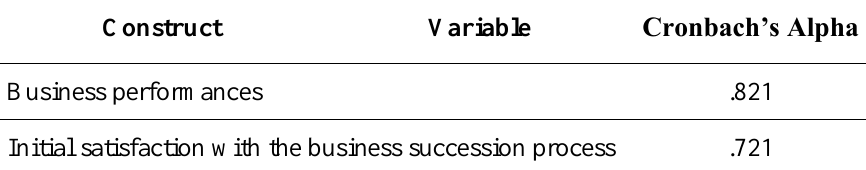
Table 2: Reliability